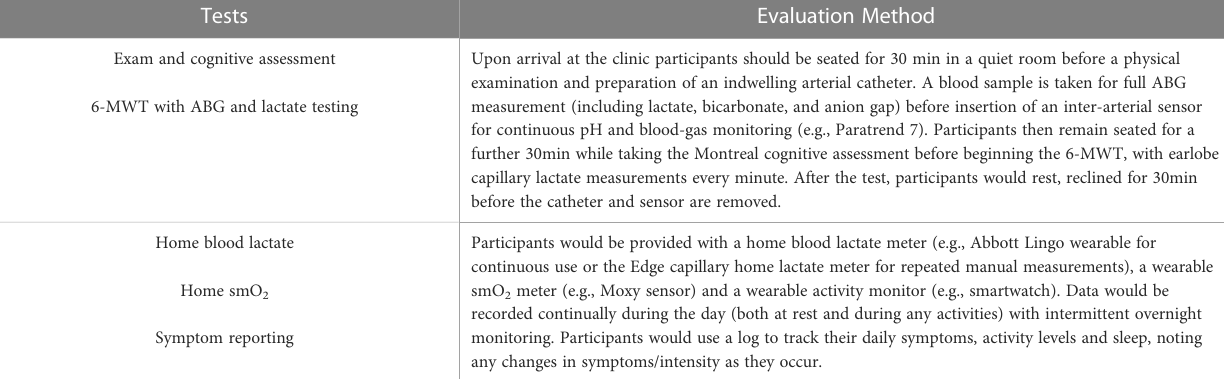
TABLE 2 Evaluating acid-base imbalances in PASC patients.